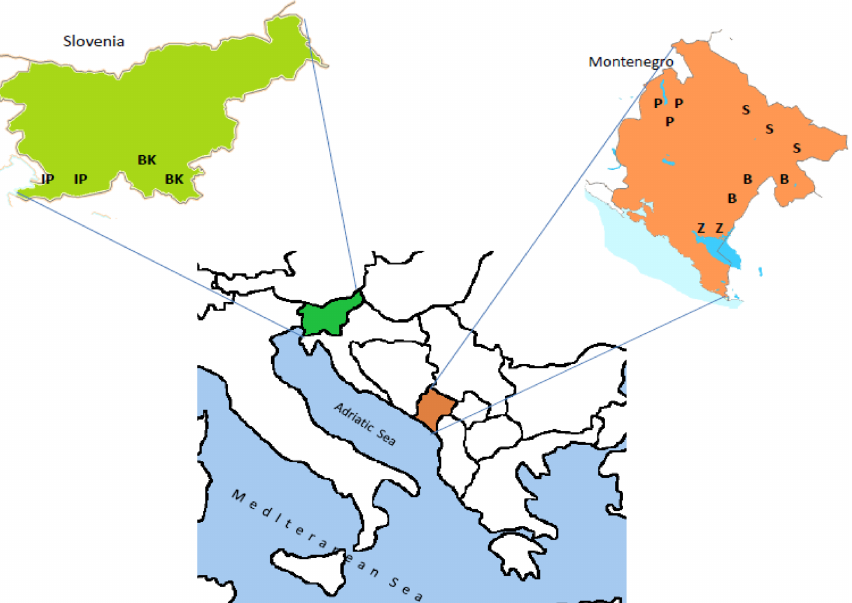
Figure 1. Rearing areas of Slovenian and Montenegrin sheep breeds. (IP – Istrian Pramenka, BK – Bela Krajina Pramenka, P – Pivska Pramenka, S – Sjeniˇcka, B – Bardoka, Z – Zeta